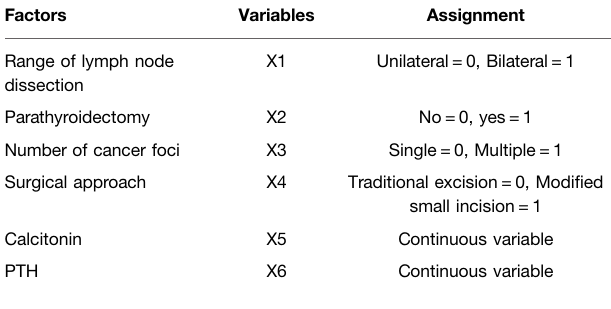
TABLE 2 | Assignment for multivariate logistic regression analysis.